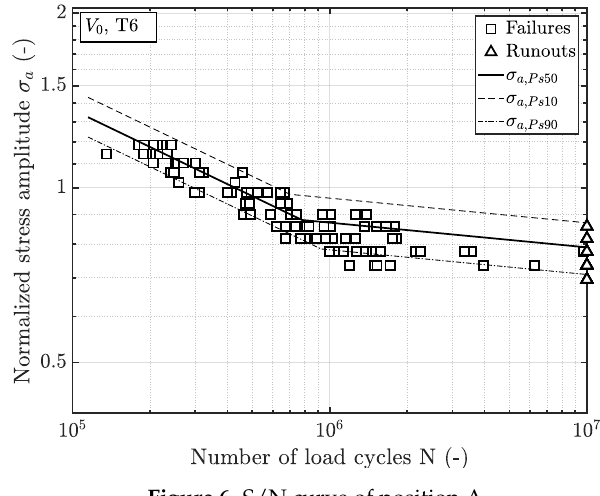
Figure 6. S/N curve of position